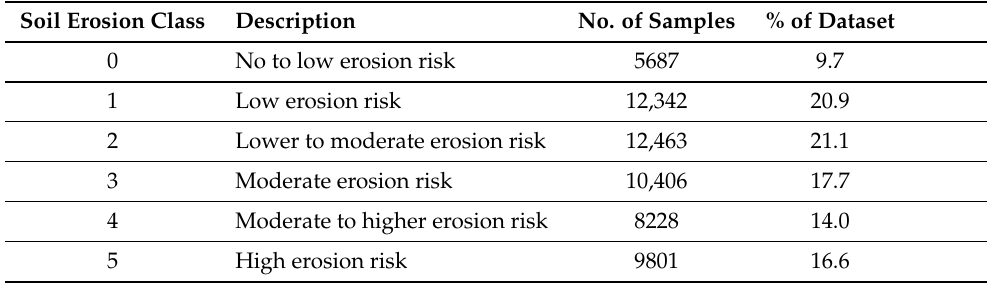
Table 1. Soil erosion classes in the training